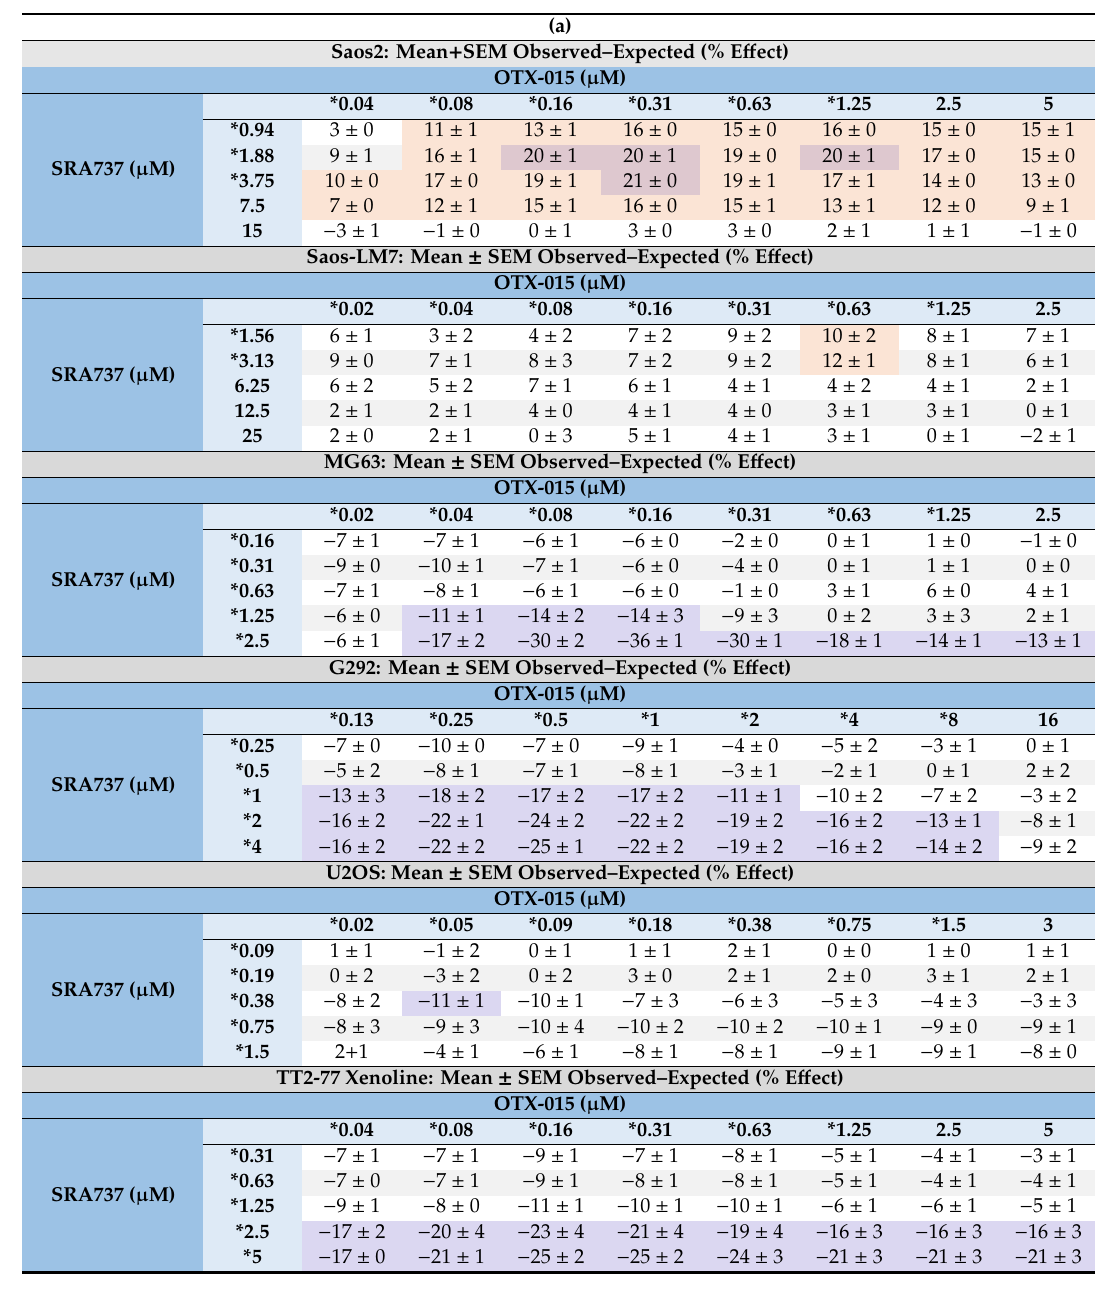
Table2. AnalysisofcellgrowthinhibitioninpediatricOScelllinestreatedwithBETandCHK1inhibitors. Established OS cells and TT2-77 OS xenoline were treated with varying dose ratios of BETi / OTX-015 and ( a ) CHK1i / SRA737 or ( b ) CHK1i / LY2606368. Cell growth was determined by methylene blue staining. E ffi cacy synergy was determined by Bliss Independence analysis. SEM = standard error mean. * Within the range of clinically achievable concentrations. Clinically achievable doses include BETi / OTX-015 (1–2 µ M) [58], CHK1i / SRA737 (6 µ M) [63], and CHK1i / LY2606368 (0.1–0.2 µ M) [74]. Data are compiled from three independent